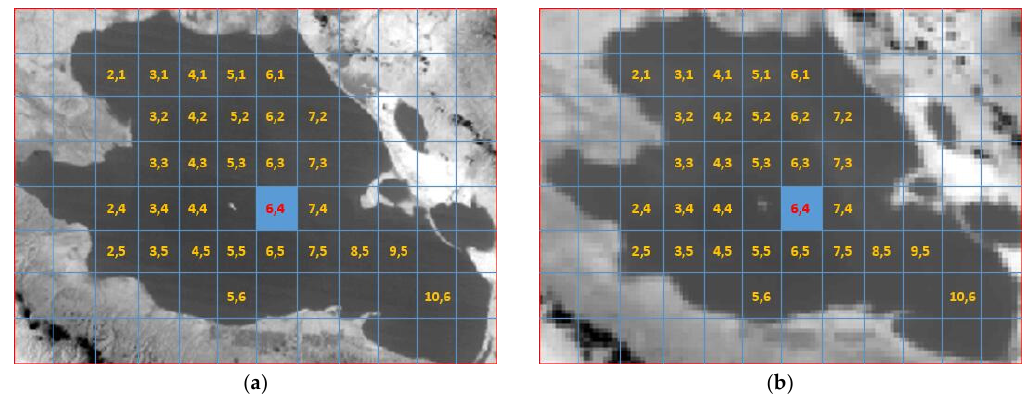
Figure 4. The most uniform and stable grid square of ( a ) IRS and ( b ) MODIS. The final region of interest